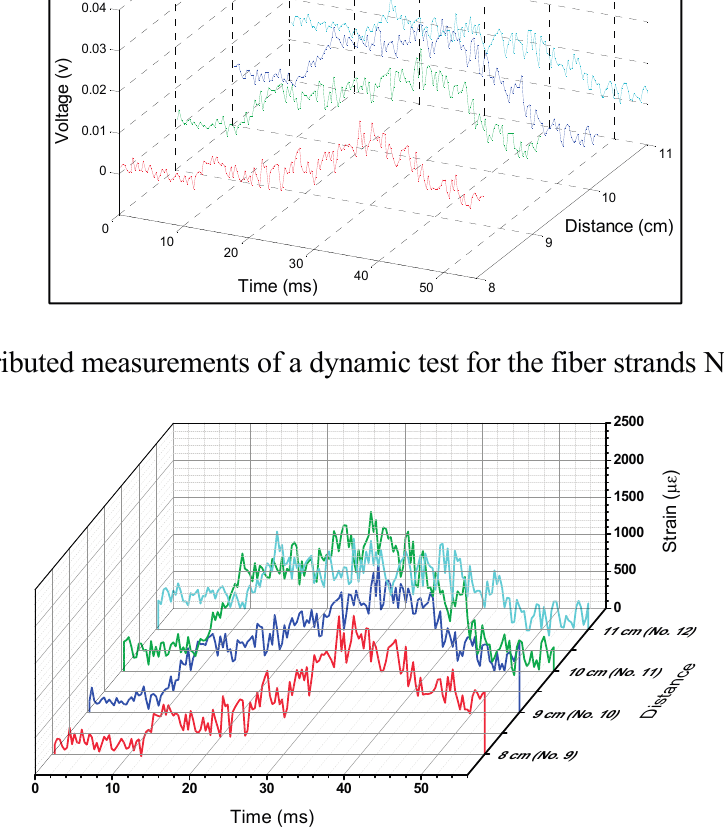
Figure 8. Computed strain amplitude